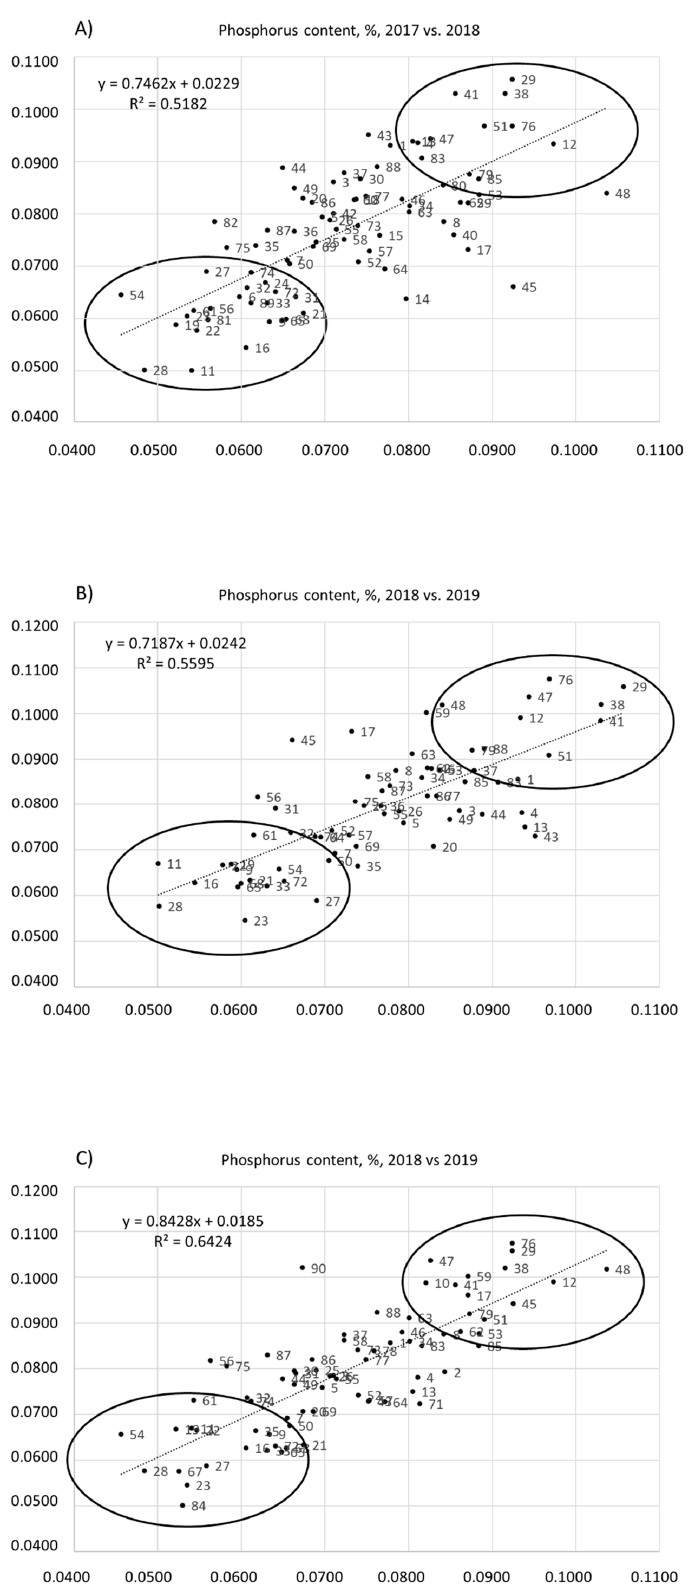
Figure 1. Pairwise correlations of phosphorus content in the starch of crops harvested in three years: ( A ) 2017 vs. 2018; ( B ) 2018 vs. 2019; ( C ) 2018 vs.